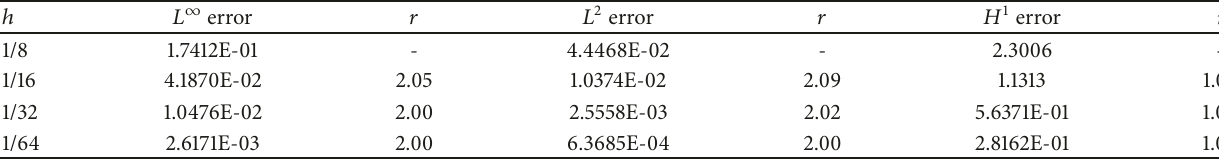
Table 1: Errors of the control for different error norms.